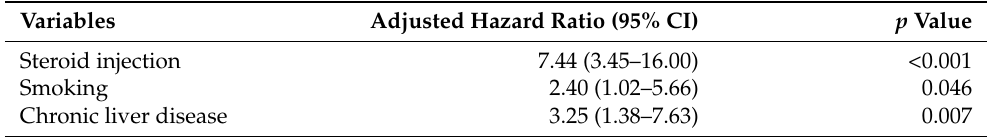
Table 3. Factors of outcomes after univariate Cox regression